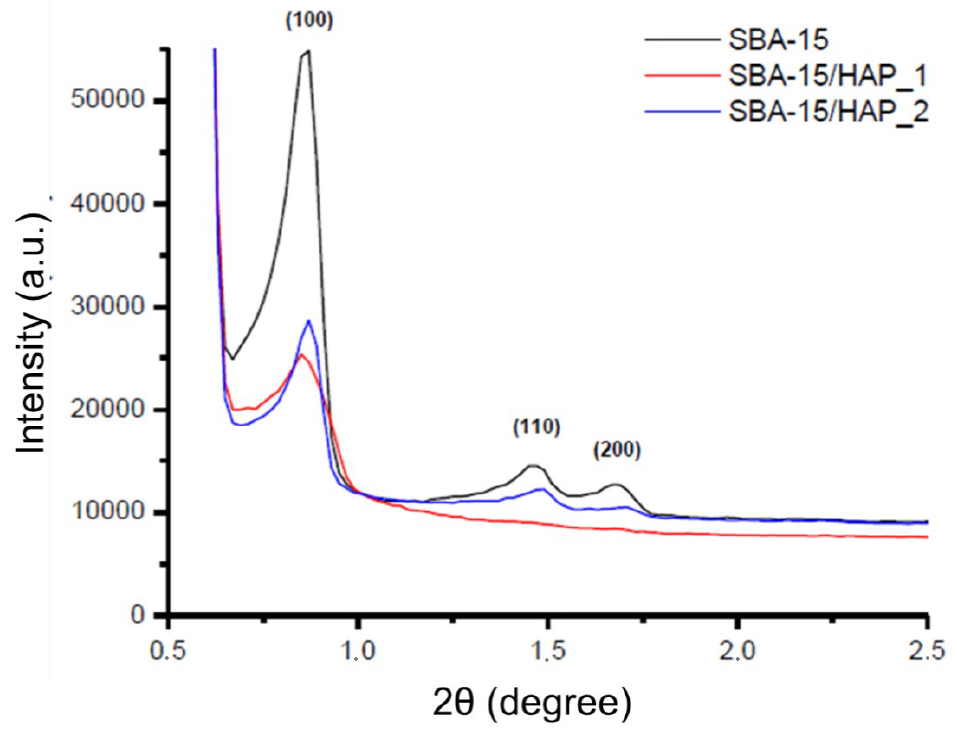
Figure 6. Small-Angle X-ray Diffraction patterns of SBA-15, SBA-15/HAP_1, and SBA-15/HAP_2. The Ca ions inside the silica network in SBA-15/HAP_1 can be confirmed by the high amount of Ca verified by elemental analysis compared with SBA-15/HAP_2. According to with the display of three peaks at 2 θ ≈ 2.5, 4.69, and 5.30 A ◦ , which are typical (100), (110), and (200) reflections of one-dimensional hexagonal (P6m) mesostructures, indicating a sig- hexagonal lattice [40].